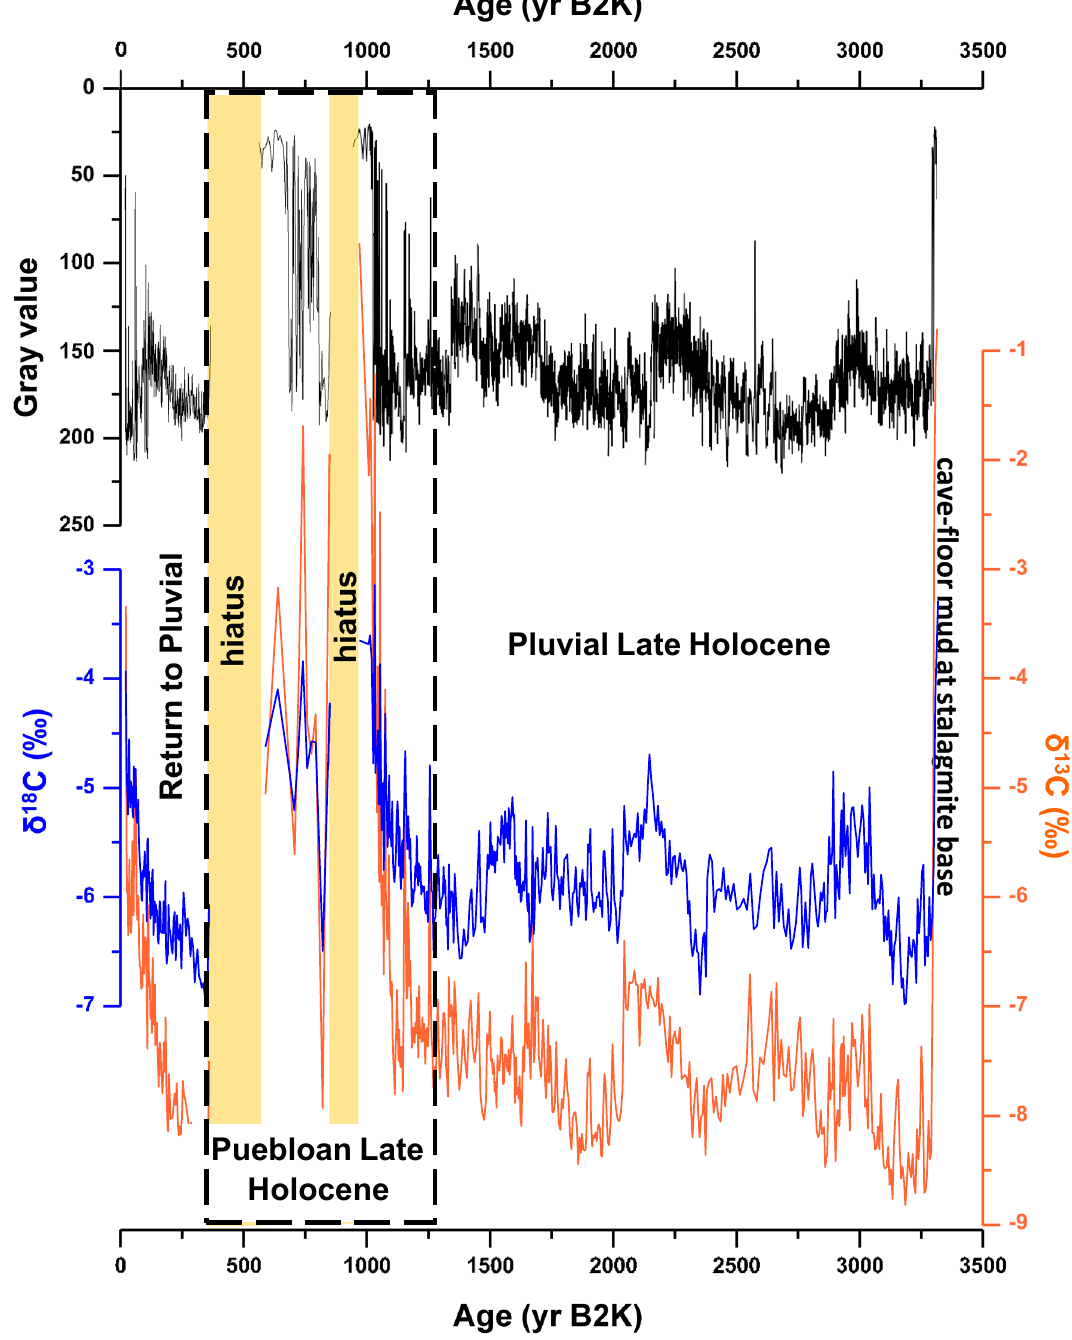
Figure 3. Stalagmite HC-1 grayscale, and stable isotope COPRA-generated time-series showing disruptions to each proxy coeval with the Pueblo period. Two significant growth hiatuses (or intervals of very slow growth) also occur during the Pueblo